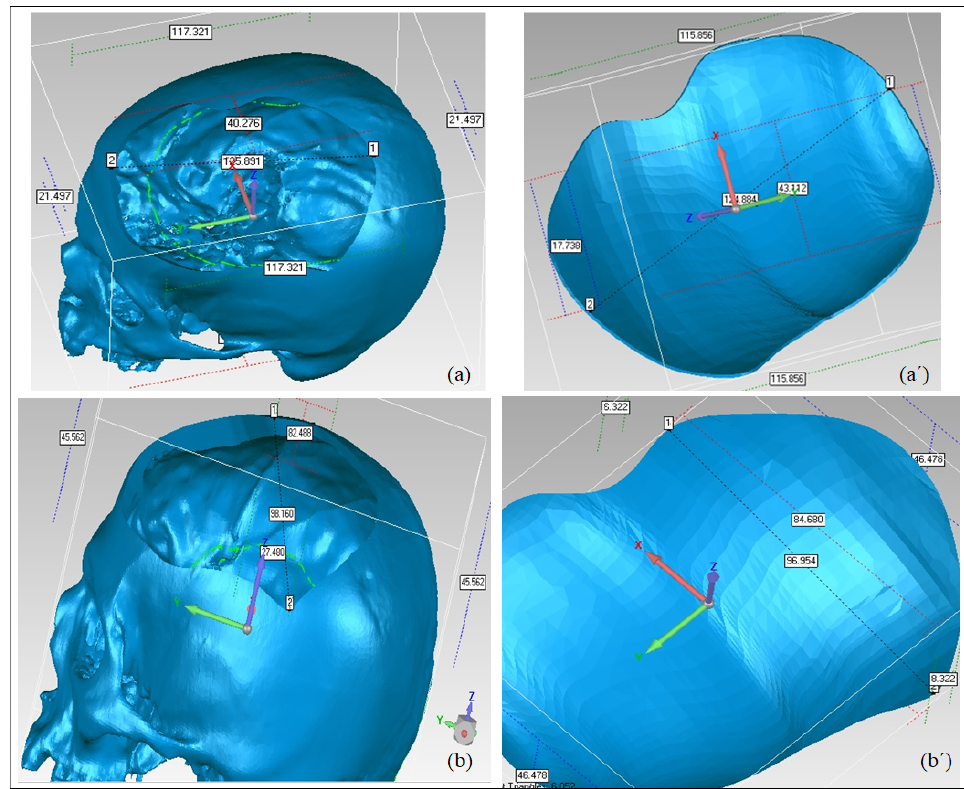
Figure 14. Gap Analysis between the implant and the skull. ( a ) Defect length in the Y ‐ direction; ( a’ ) implant length in the Y ‐ direction; ( b ) defect width in the X ‐ direction; ( b’ ) implant width in the X ‐ direction.